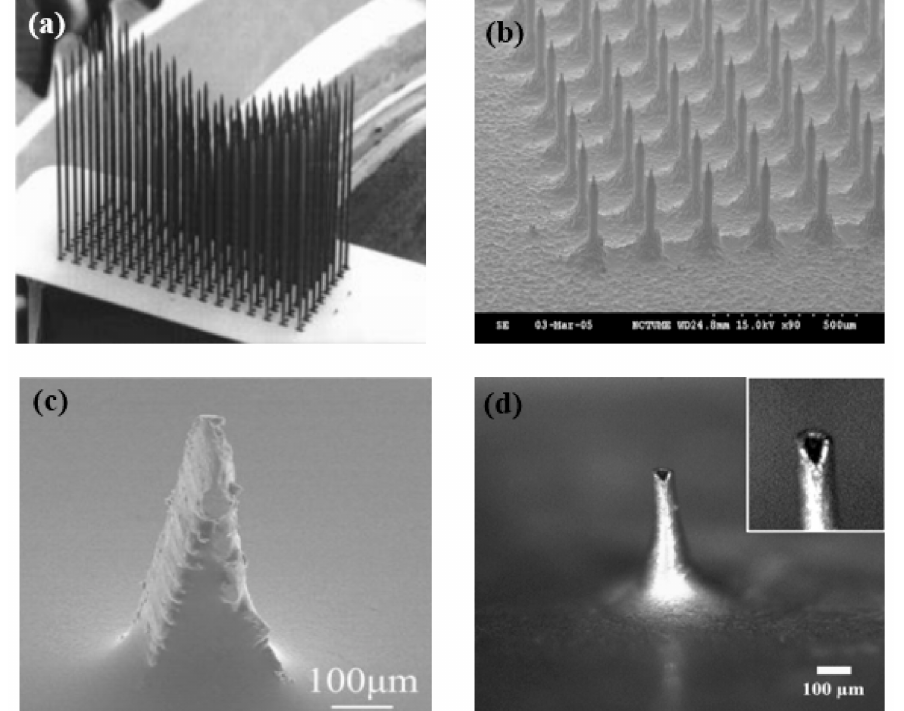
Figure 6. Typical MEMS electrodes and capacitive electrodes. ( a , b ) Silicon-based microneedle array dry electrodes [68,70]. ( c ) Metal microneedle array electrodes [74]. ( d ) Polymer-based microneedle array dry electrode